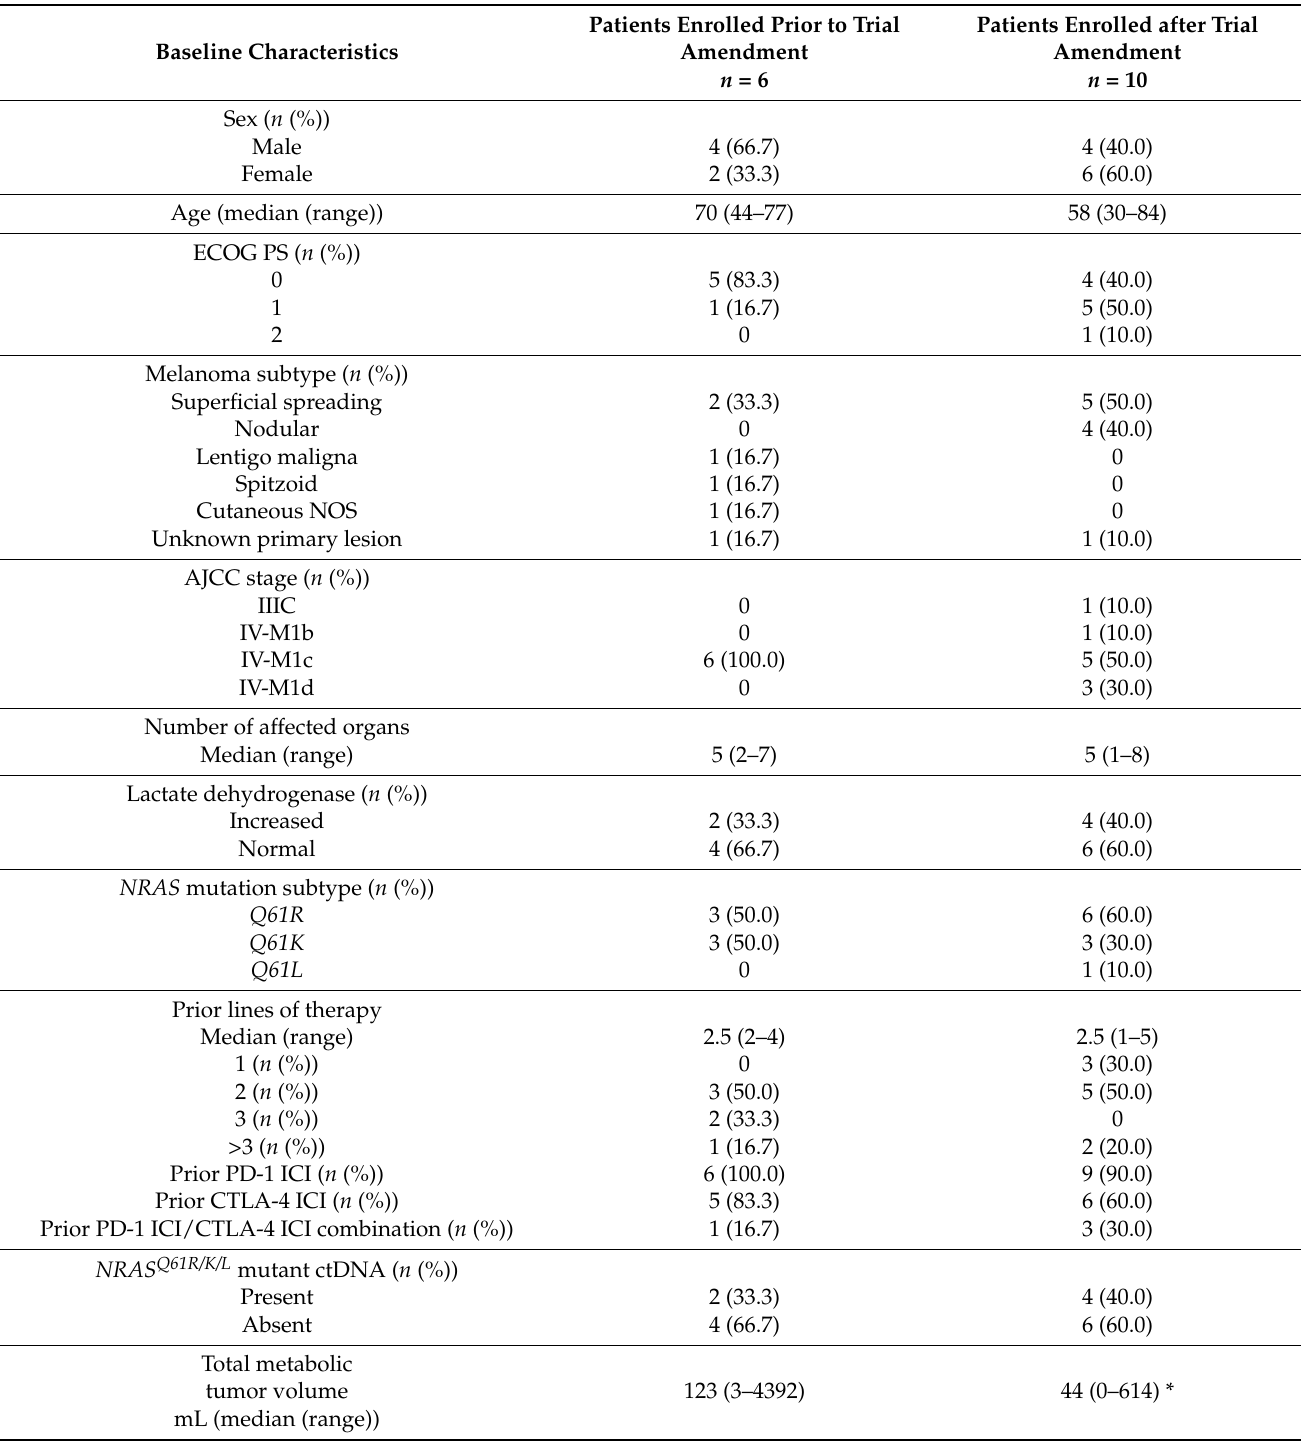
Table 1. Baseline characteristics of patients enrolled prior to and after trial